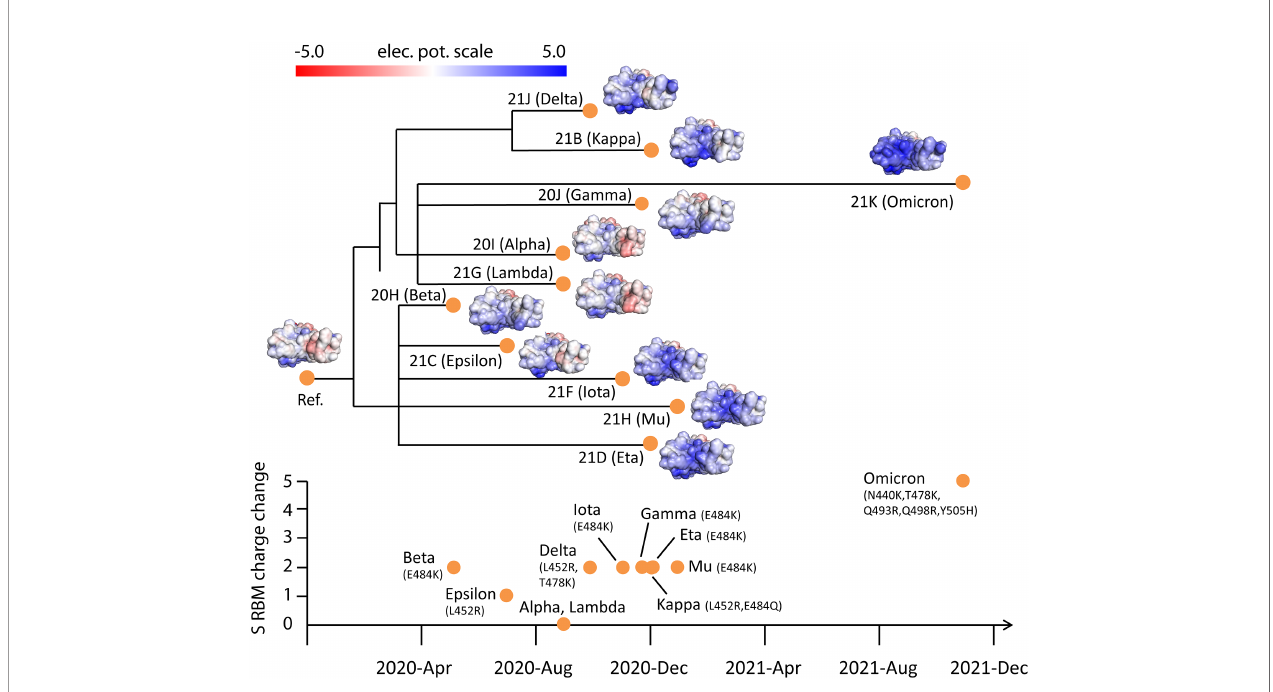
FIGURE 2 | Electrostatic surfaces of Spike RBD variants organized by Nextstrain SARS-CoV-2 phylogeny. Tracking of total charge changes with accompanying mutations in S RBM suggests a gradual increase of positive charges over time. The color scale of the electrostatic potential surface is in units of kT/e at T =